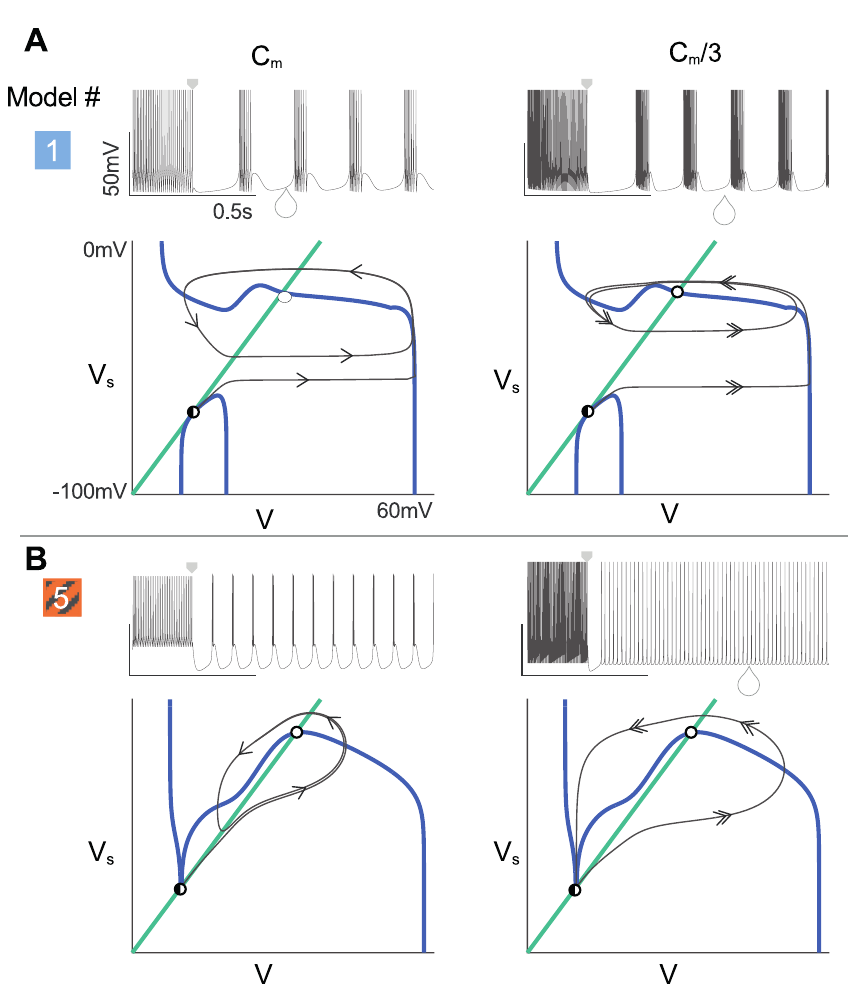
Fig 7. The slow activation of T-type calcium channel reveals the appearance of a lower branch in the V-nullcline providing robustness to parameter variation. A-B : (top) Recording of the membrane voltage during a hyperpolarized-induced bursting (bottom). Phase portrait at the saddle node bifurcation. V-(resp. Vs-) nullcline is sketched in blue (resp. green). The square arrow indicates the hyperpolarizing current step. The unstable fixed point is marked by an open circle and the saddle point meeting the stable fixed point is indicated by the black half-circle. The trajectory is sketched in gray and the arrow indicates the speed along the x-axis. (left to right) the membrane capacitance is divided by 3. The velocity along the x-axis is increased. A : The V-nullcline exhibits a lower branch making the phase portrait robust to membrane capacitance variation due to the sharp separation between the limit cycle and the hyperpolarized state. B : When the membrane capacitance is divided by three, the reduced model 5 is no more able to switch from tonic to burst. Small deviations destroy the rest-spike bistability. Videos of the different simulations are available in S5 Video to S8